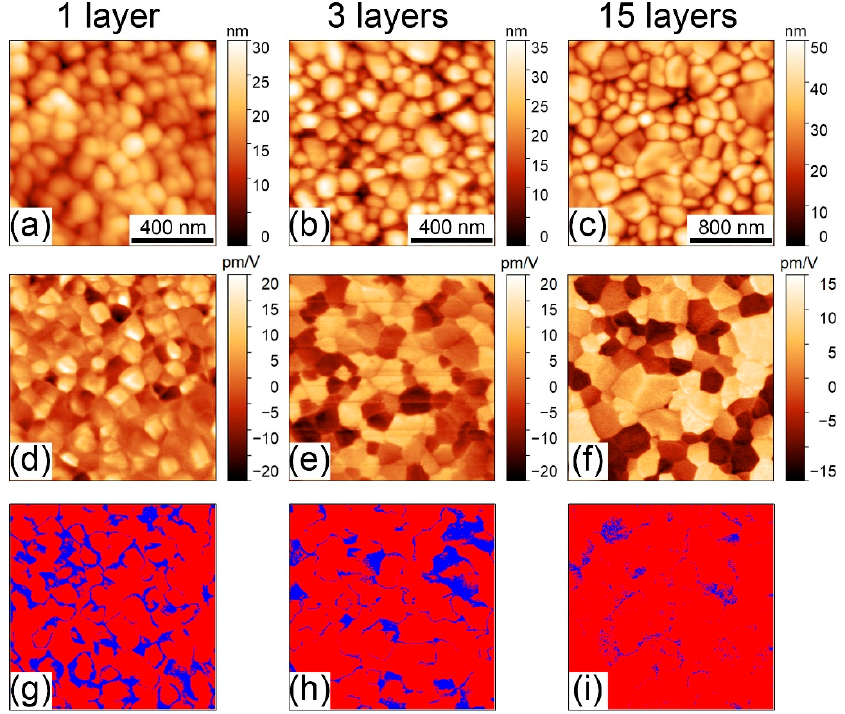
Figure 5. PFM images and phase distribution images in: ( a , d , g ) one-layer; ( b , e , h ) three-layer; ( c , f , i ) 15-layer LTD BFO films. ( a – c ) Topography; ( d – f ) vertical PFM images; ( g – i ) distribution of the piezoelectrically-active (red) and non-active (blue) phases. Table 2. Phase distribution and piezoelectric coe ffi cient for the LTD BFO thin films depending on thickness. Thickness 1 Layer